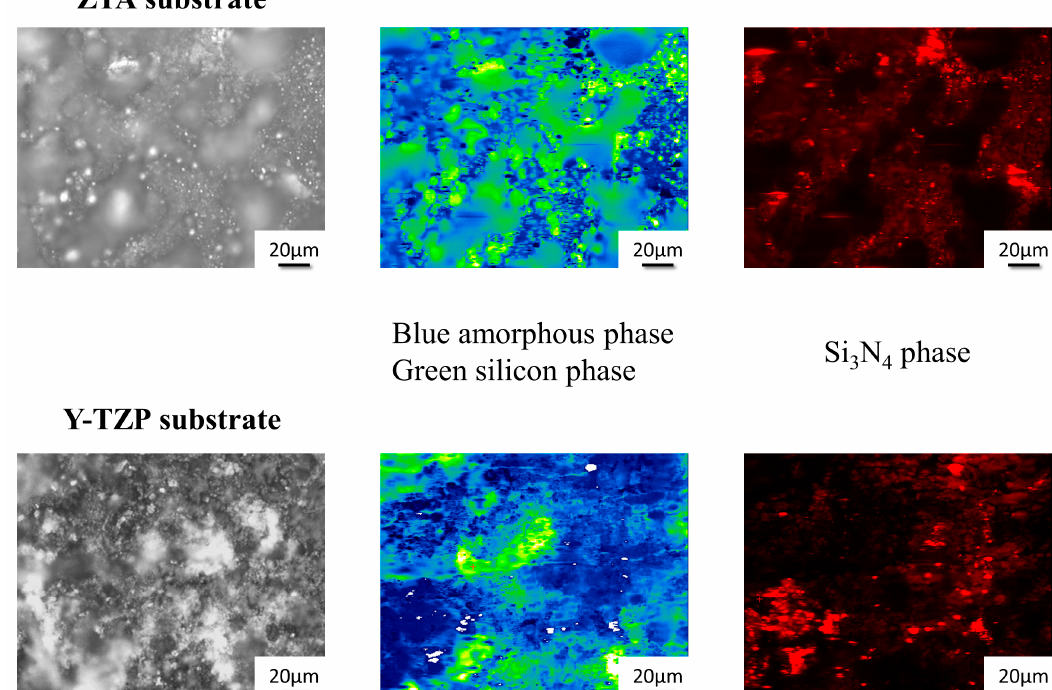
Figure 5. Raman imaging maps of coated ZTA and Y-TZP substrate.